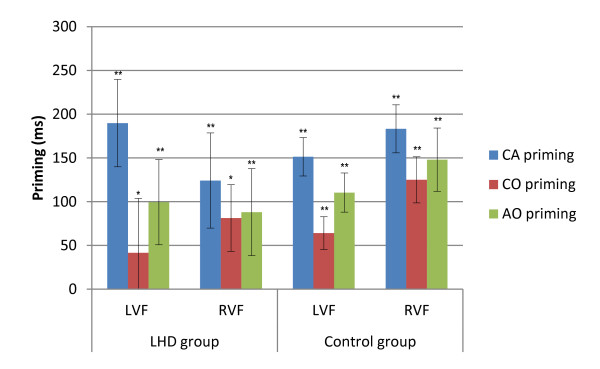
Reaction time priming effects for LHD and Control groups in the six-word memory condition. Illustrated priming effects represent the mean of individual priming effects in milliseconds (Unrelated - Related condition RT) for each condition. Error bars represent +/- 1 Standard Error. LHD = Left hemisphere damage group; Control = Control group; CA = Category Association; CO = Category Only; AO = Association Only; UNR = Unrelated; LVF = Left visual field; RVF = Right visual field; SOA = stimulus onset asynchrony; * p ≤ .05; ** p ≤ .001.